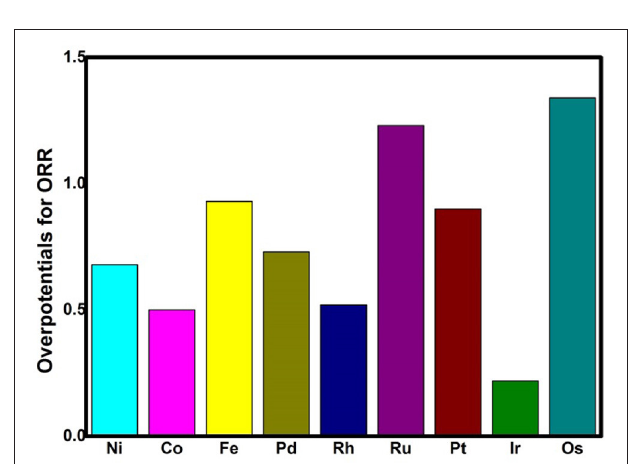
FIGURE 6 | The overpotentials µ ORR of the TM 3 (HITP) 2 monolayer for the 4 e − mechanism.